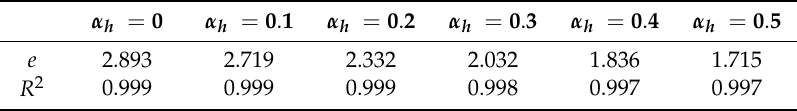
Table 3. Fitting parameters of Type B cell